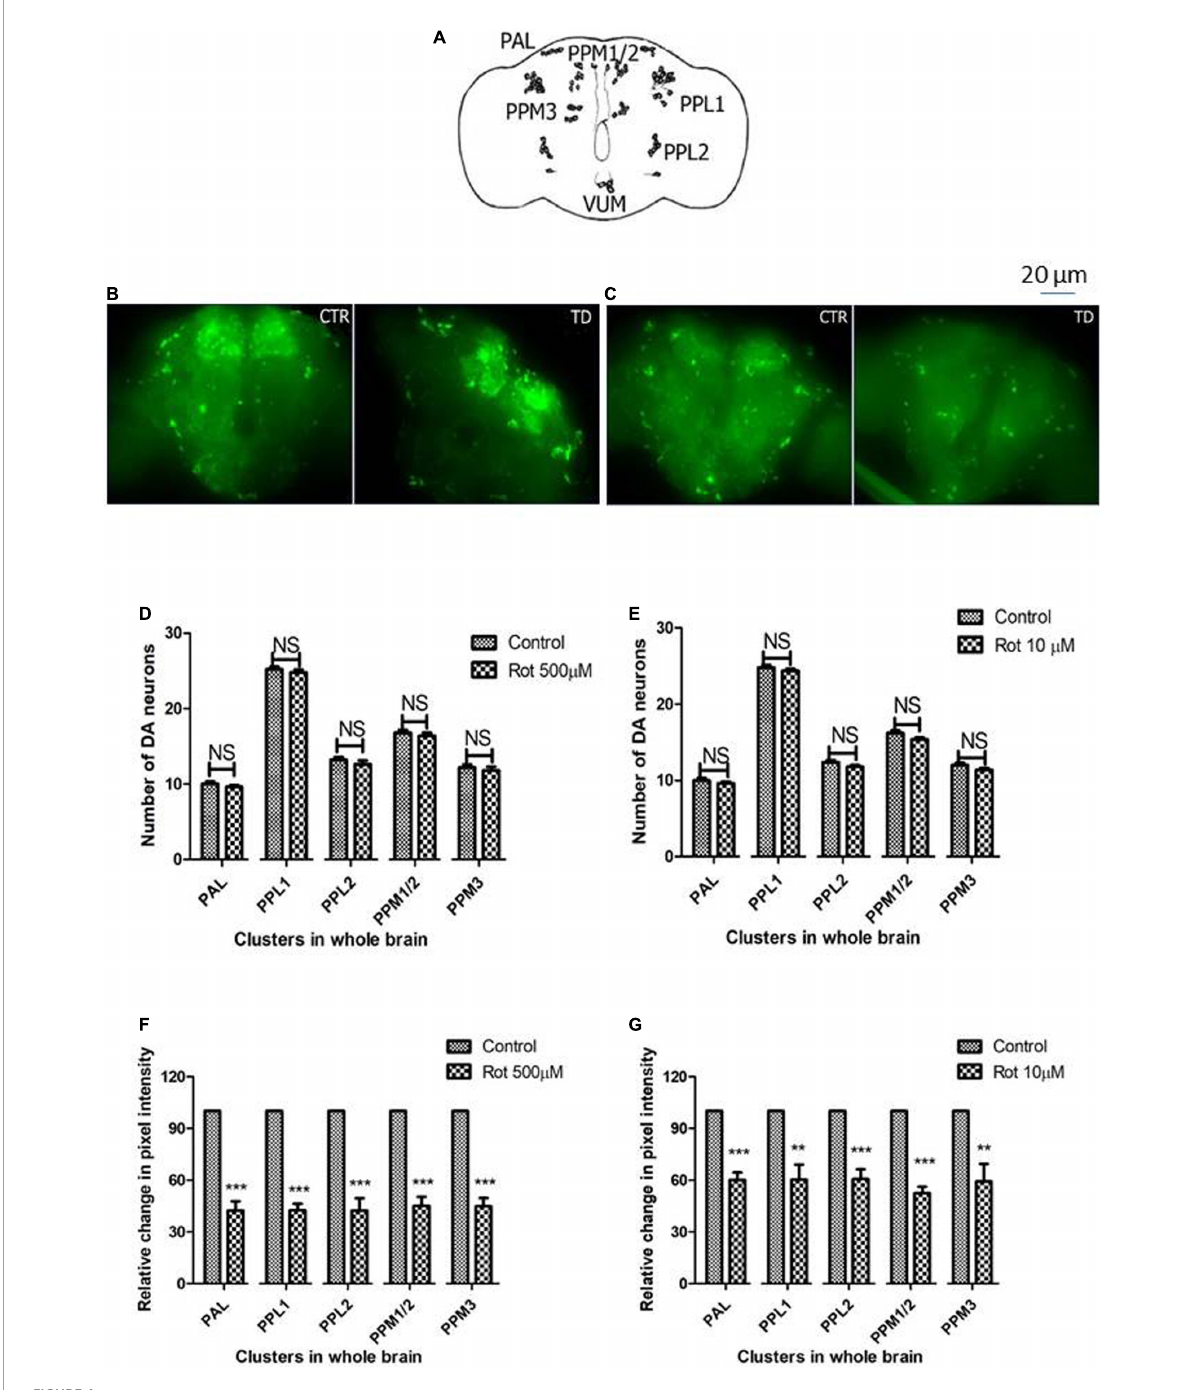
FIGURE4 Characterization of DAergic neurodegeneration in the whole fly brain through anti-TH antibody immunostaining reveals that there is no loss in the number of DAergic neurons. However, rotenone leads to “neuronal dysfunction” as characterized by quantification of DAergic neuronal fluorescence intensity that is proportional to the amount of TH protein. Cartoon showing the position of DAergic neurons in the whole brain of Drosophila melanogaster (A) . Brain image of control and induced PD conditions during early health span (B) and transition phase (C) . Quantification of DAergic neurons reveals that there is no loss of neuronal number per se in both life stages, early health span (D) , and transition phase (E) , whereas the quantification of fluorescence intensity (of fluorescently labeled secondary antibodies that target primary antibody anti-TH) reveals a significant decrease in TH protein in both life stages, that is, health stage (F) and transition stage (G) . CTR, Control; TD, Treated with rotenone; PAL, Protocerebral anterior lateral; PPL, Protocerebral posterior lateral; PPM, Protocerebral posterior medial. Statistical analysis was performed using a t -test (compared to control). ** p < 0.01, *** p < 0.0001, NS,